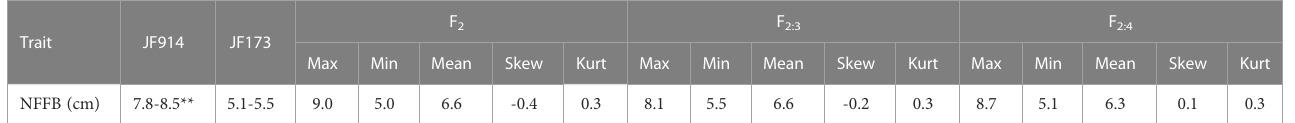
TABLE 1 The statistics of NFFB in the parents, F 1 , and segregated populations.